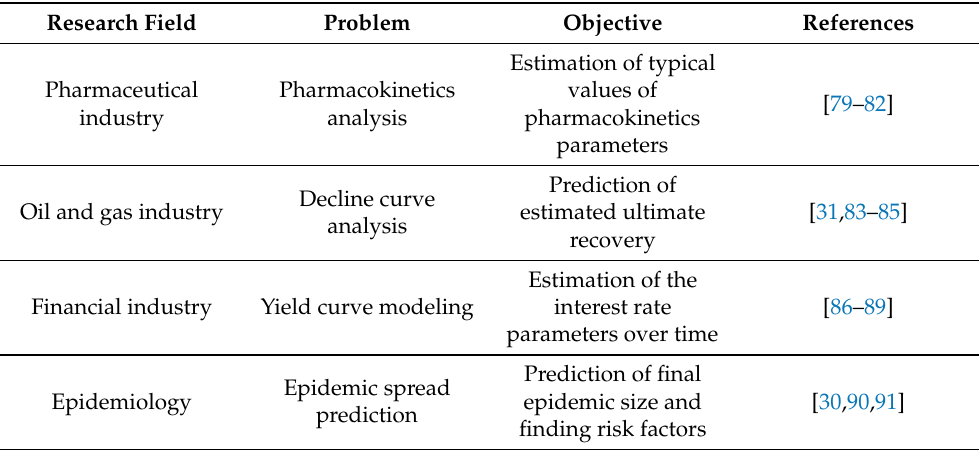
Table 2. Summary of